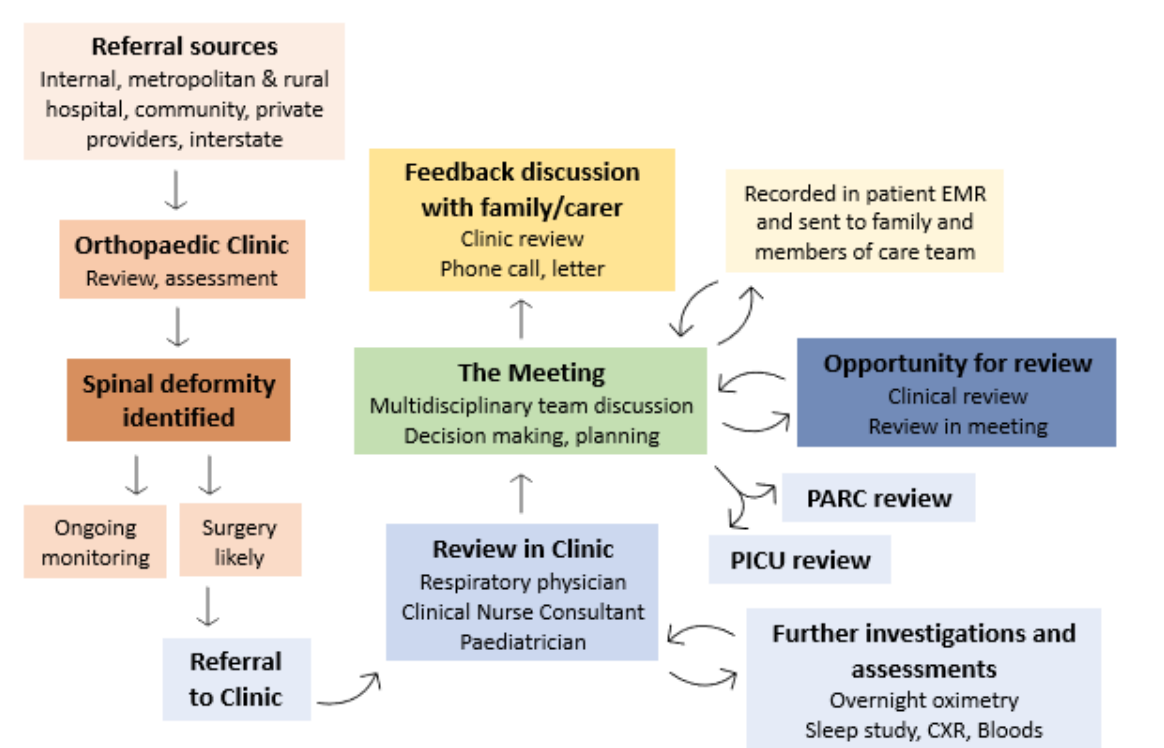
Figure 1. Description of clinical assessment and process of the Clinic and the Meeting. A summary of the outcomes of the clinical case conference, which includes further investigations and details of the peri-operative plan are included in the patient Electronic Medical record (EMR), allowing for access for all members of the team as a reference point for peri-operative management and admis- sion. (PARC—pre-anaesthetic review clinic, PICU—Paediatric Intensive Care Unit, CXR—Chest X- ray).